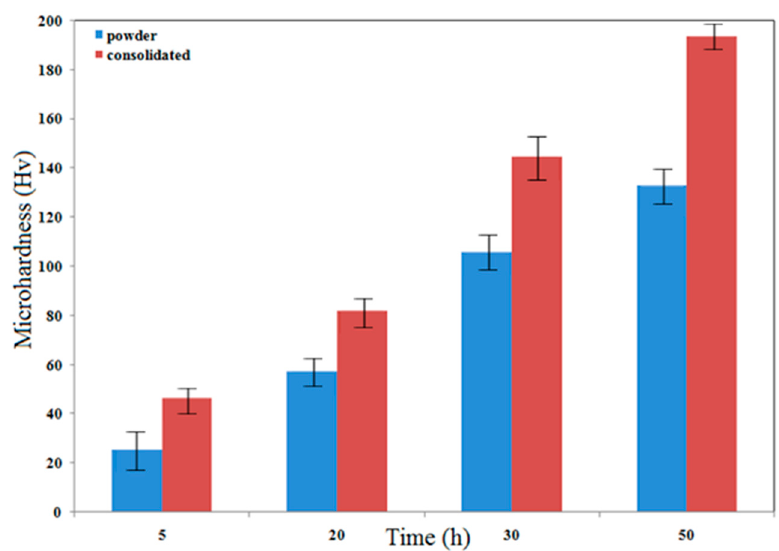
Figure 5. Microhardness values (Hv) of Al–5 wt %Si powder and consolidated samples as a function of the milling time (h).